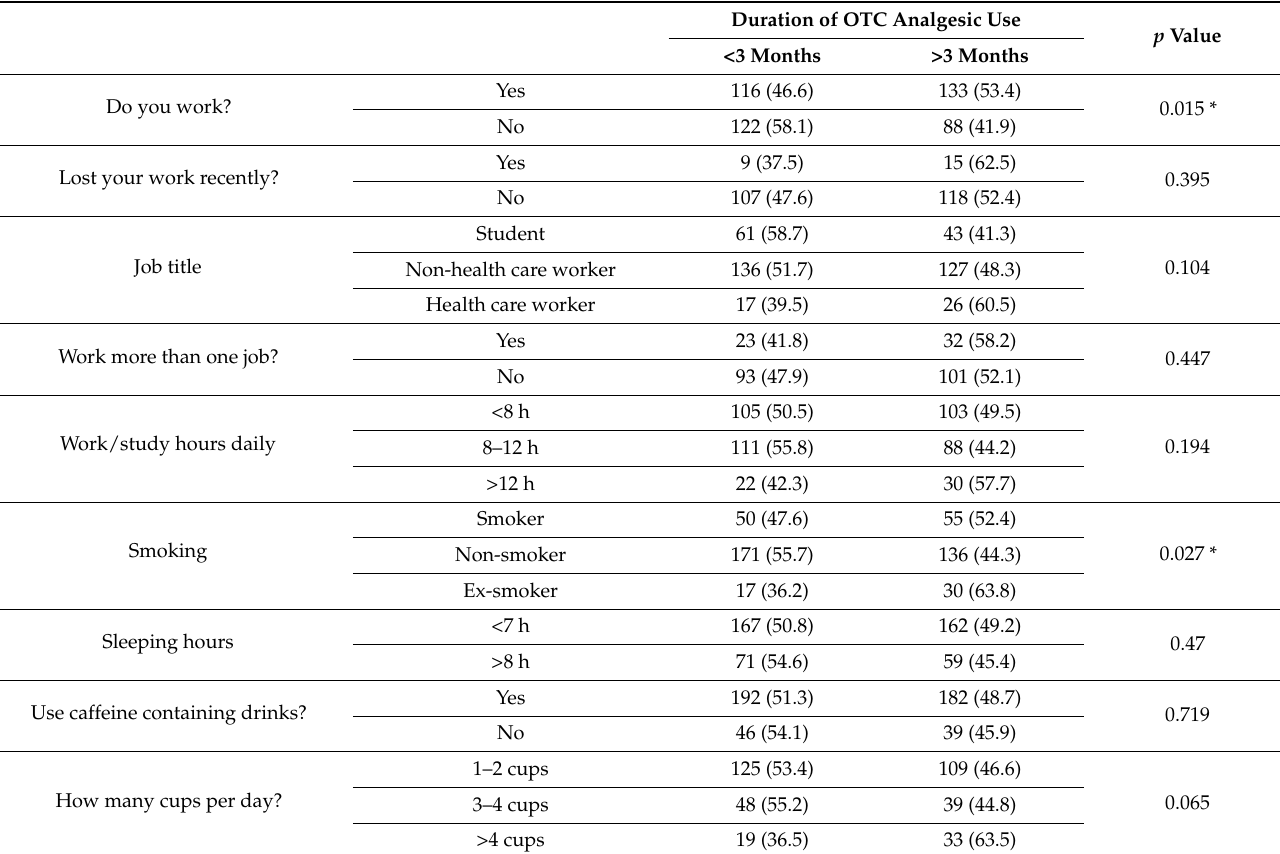
Table 2. The association between lifestyle factors and OTC analgesic overuse.